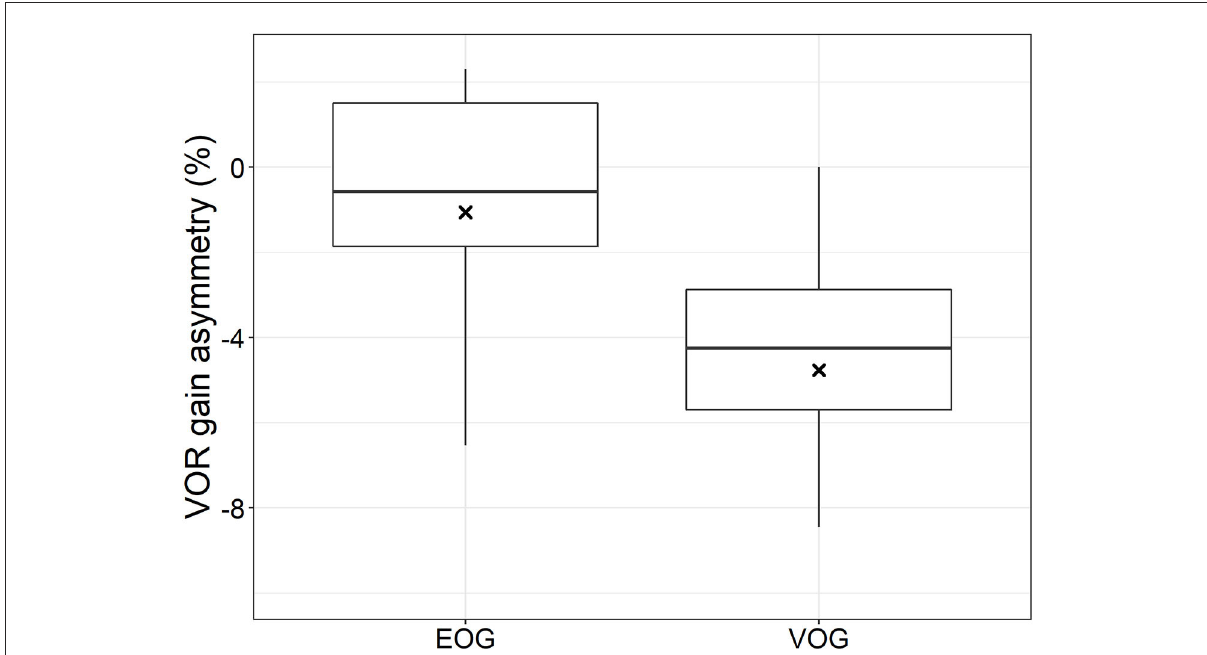
FIGURE3 Boxplot: left-right asymmetry in VOR gain calculated for EOG and VOG obtained traces. Black crosses indicate mean values, black bars indicate medians, boxes represent first and third quartiles, and dots represent